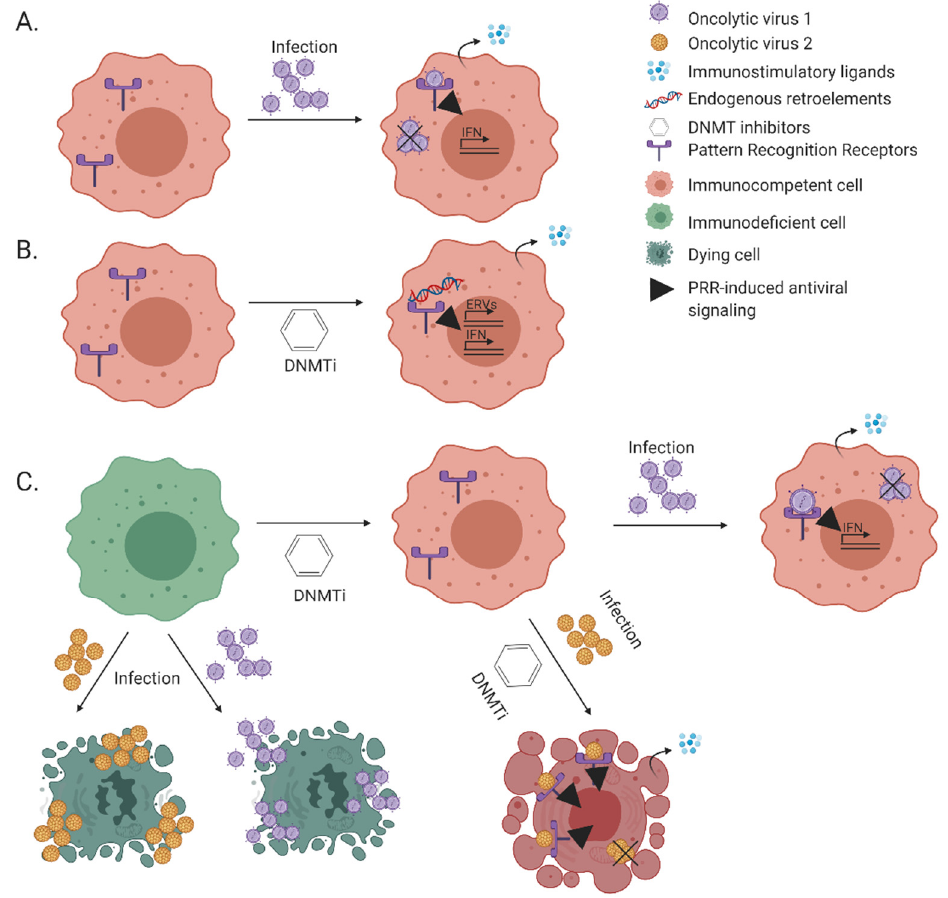
Figure 3. Immuno-stimulation: the interplay between OVs and DNMTis. ( A )—Infection of oncolytic virus is aborted in an immunocompetent tumor cell in a process involving PRR-mediated PAMP sensing and secretion of immunostimulatory ligands, e.g., interferons. ( B )—Immunocompetent tumor cells, when treated with DNMTis, may express endogenous retroelements and sense their products. This process is termed viral mimicry. The secreted immunostimulatory cytokines (in A or B) may act in autocrine or paracrine fashions, to induce anti-proliferative/cell death effects at the level of the cancer cell, and/or immune-mediated anti-tumorigenic effects (not depicted for sake of simplicity). ( C )—The subset of immunodeficient cancer cells (green cells) can be killed directly by replicating oncolytic virus. DNMTi treatment renders them immunocompetent (green to pink shift). When combined with oncolytic viruses, the outcome of such treatment depends on the identity of the oncolytic virus. In a subset of cases (e.g. with EHDV-TAU, yellow viruses) the combined treatment induces cell death, in spite of the DNMTi-mediated reduction in viral replication (as in [152]). The figure was created with BioRender.com (accessed on 12 February 2021).